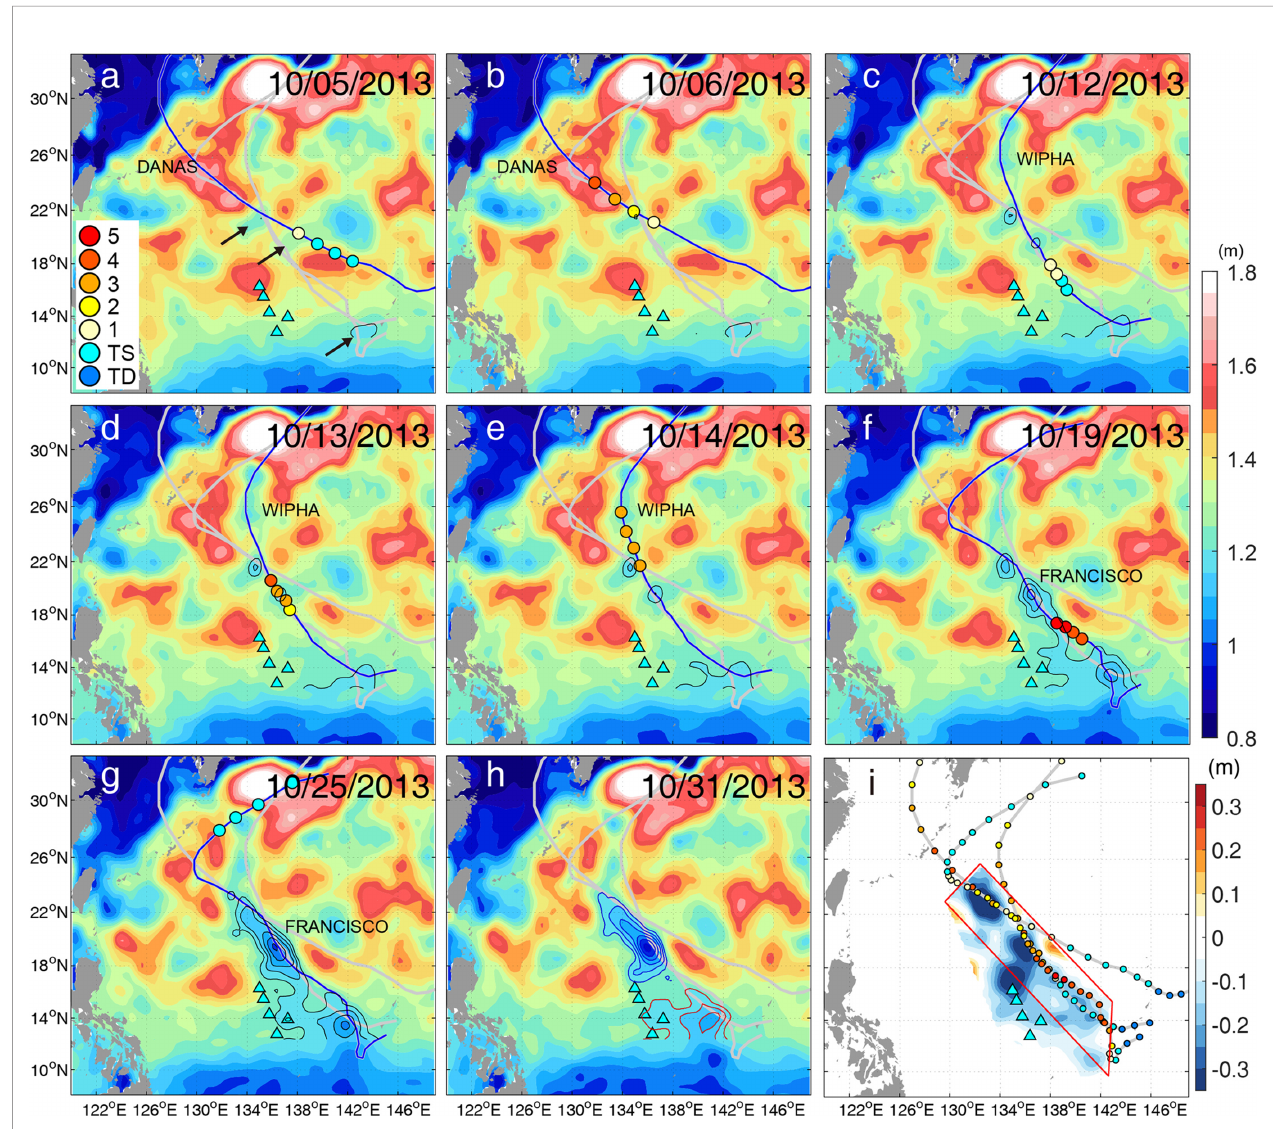
FIGURE 4 | Snapshot of sea-surface height (SSH) maps in the western Paci fi c during typhoon passages in October 2013. (A) SSH maps on October 5 th , (B) October 6 th , (C) October 12 th , (D) October 13 th , (E) October 14 th , (F) October 19 th , (G) October 25 th , and (H) October 31 st . Typhoon tracks (gray and blue lines) and Saf fi r – Simpson scale (color dots every 6 h) at 00, 06, 12, and 18 h GMT on each day. Pressure-recording inverted echo sounder (PIES) mooring sites are marked with cyan triangles. Black contours in (a – g) and blue and red contours in (H) indicate SSH lows from 0.9 to 1.2 m with 0.05 m intervals. (I) SSH difference between October 5 th and October 31 st superimposed by three typhoon tracks (gray solid line) with Saf fi r – Simpson scale. Red trapezoid indicates the region where ocean heat content (OHC) changes are